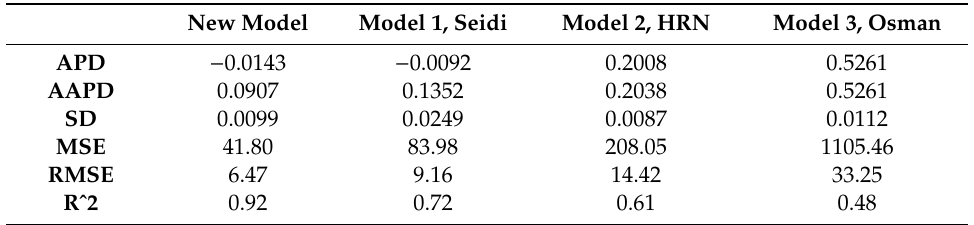
Table 11. A comparison of six di ff erent measures of accuracy corresponding to di ff erent models using the production data set of the 160 / 64 inch choke size.